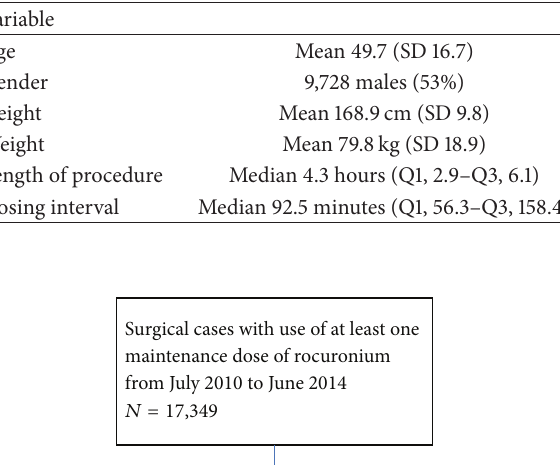
Table 1: Demographic, procedure, and dosing statistics.